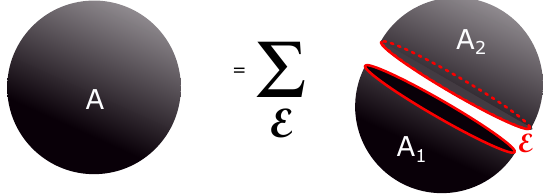
2 (cid:0) A 2 E 2 2 e 2 . Fixing the value of E for a manifold with boundary